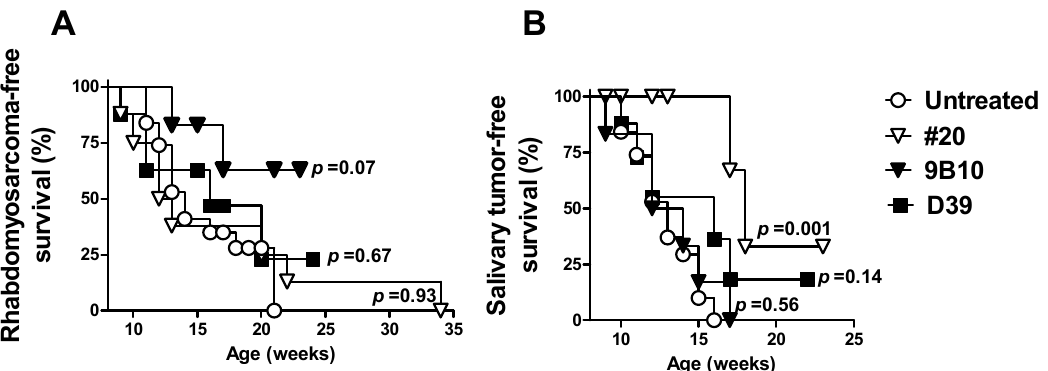
Figure 4. Effect of mIGF1R- or hIGF1R-expressing cell vaccines on the onset of spontaneous rhabdomyosarcoma ( A ) and salivary carcinoma ( B ) in BALB-p53Neu mice. Tumor-free survival (%) is shown. Symbols: Open circles, untreated control mice ( n = 15); open triangles: #20 cell vaccine ( n = 8); closed triangles: mIGF1R-expressing 9B10 cell vaccine ( n = 6); squares: hIGF1R-expressing D39 cell vaccine ( n = 8). Statistical significance (Mantel–Haenszel test) vs. untreated is reported in the figure. Statistical significance vs. #20 parental cell vaccine is as follows: For rhabdomyosarcomas, D39 p = 0.65, and 9B10 p = 0.10; for salivary tumors, D39 p = 0.12 and 9B10 p = 0.006.